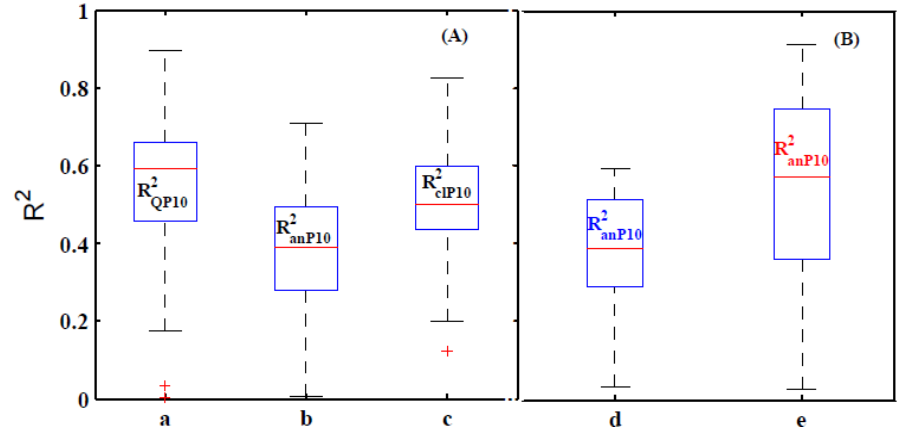
Figure 6. ( A )The boxplots (a)–(c) are for the coefficient of determination (written in black) values of the relationships between k and Q P10 (R 2 ), k and S anP10 R 2 , and between k and S clP10 ( R 2 ), respectively, considering the 51 study basins. Figure 6, panel ( B ) is for 18 basins in which figure (d) is the boxplot for coefficient of determination (written in blue color) for the condition when only discharge decreases with time. (e) shows boxplot for the same 18 basins, considering only the recession events during which both Q and S an continuously decreases with time.